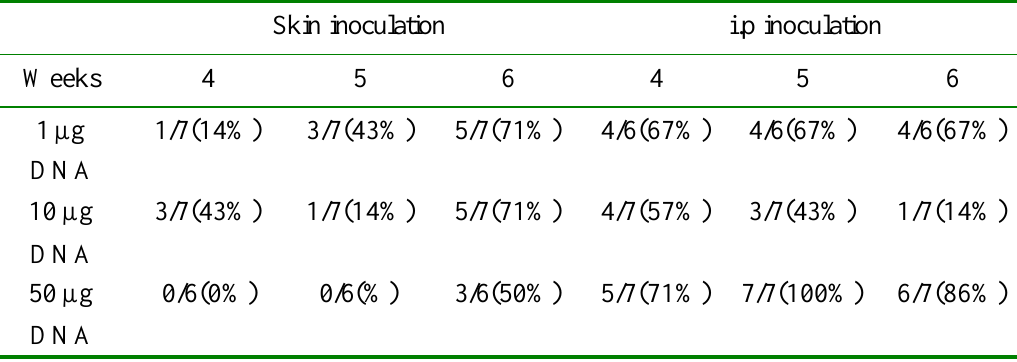
Table 2, and lower dose of DNA-liposome complexes can elicit higher anti-HBsAg antibody response and more frequency of high positive responses. The antibody titer of 1µg DNA is 512 and frequency of high positive response is 71% (5/7) at six weeks, which is higher than those of 50µg. It indicated